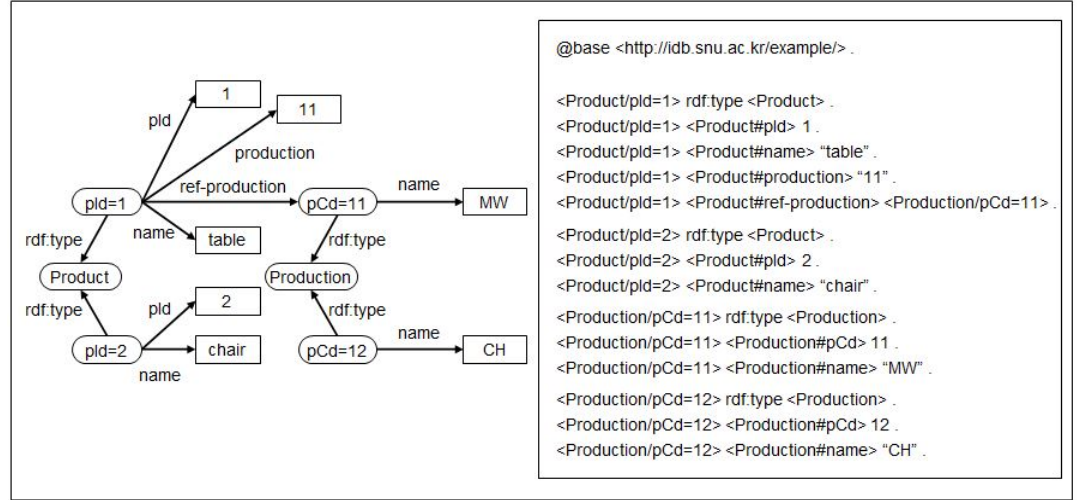
Figure 4. An example input relational data of the direct mapping.